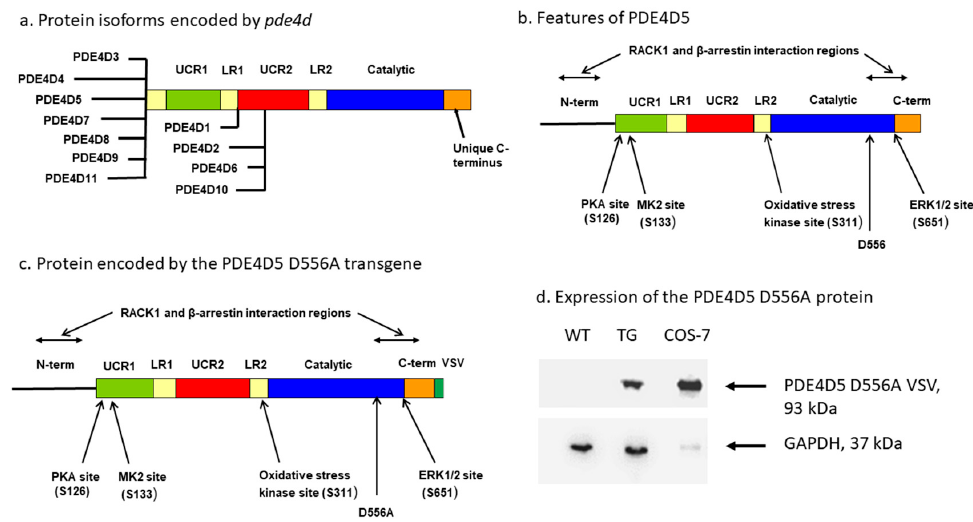
Figure 1. ( a ) Proteins encoded by the human PDE4D gene [73,88,96–100]. The long isoforms PDE4D3, PDE4D4, PDE4D5, PDE4D7, PDE4D8, PDE4D9, and PDE4D11 all contain UCR1, UCR2, and catalytic